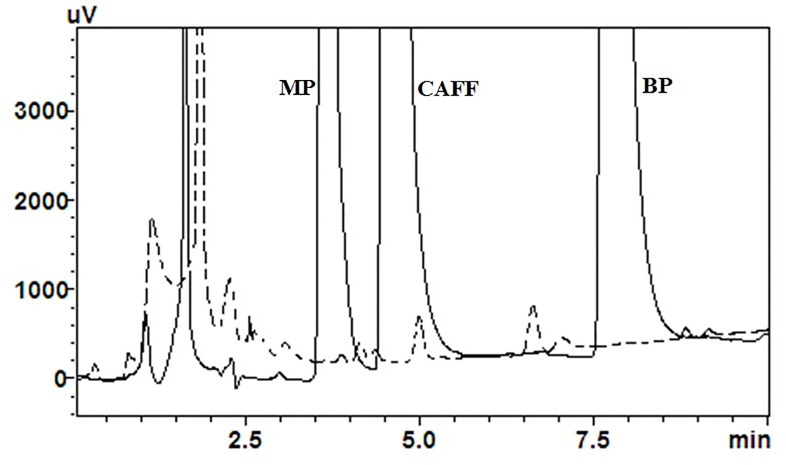
Comparison between the chromatogram for the mixture of analytes (continuous line) and that of the matrix (dotted line).The concentration of the mixture is 25 μg/mL with respect to each analyte.